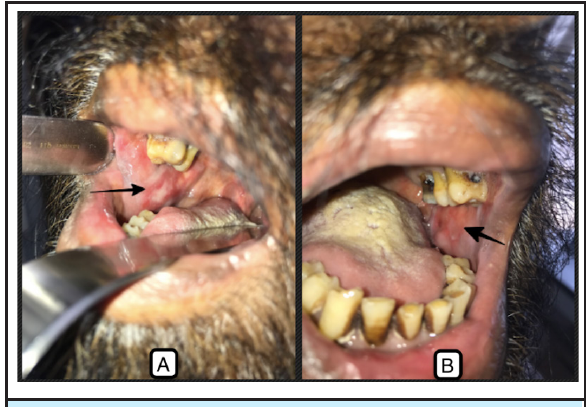
Figure 1. Superficial, erythematous, well defined, non-indurated, mucosal ulcerative lesions involving bilateral buccal mucosa.